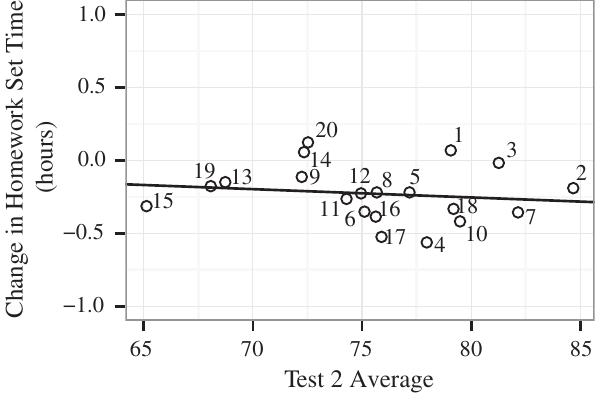
FIG. 4. Change in homework set time vs test 2 average by